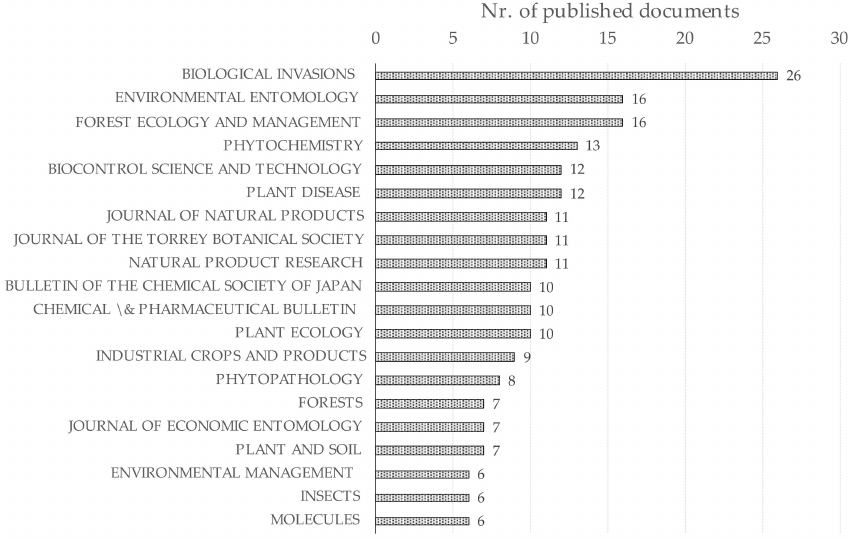
Figure 4. List of the most representative and relevant sources for the set of keywords “Ailanthus” and